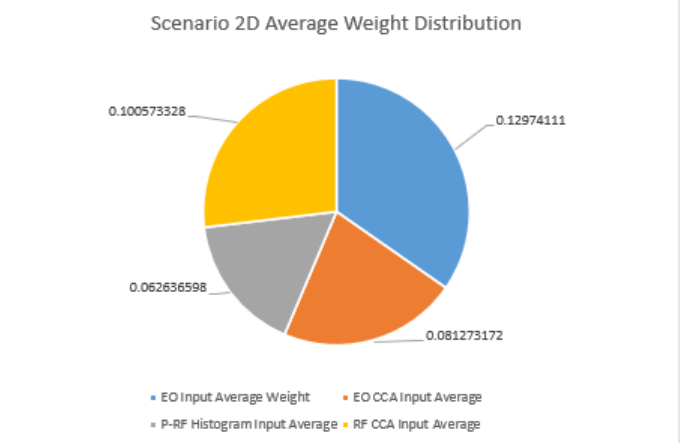
Figure 7. Comparison of average weights for Scenario